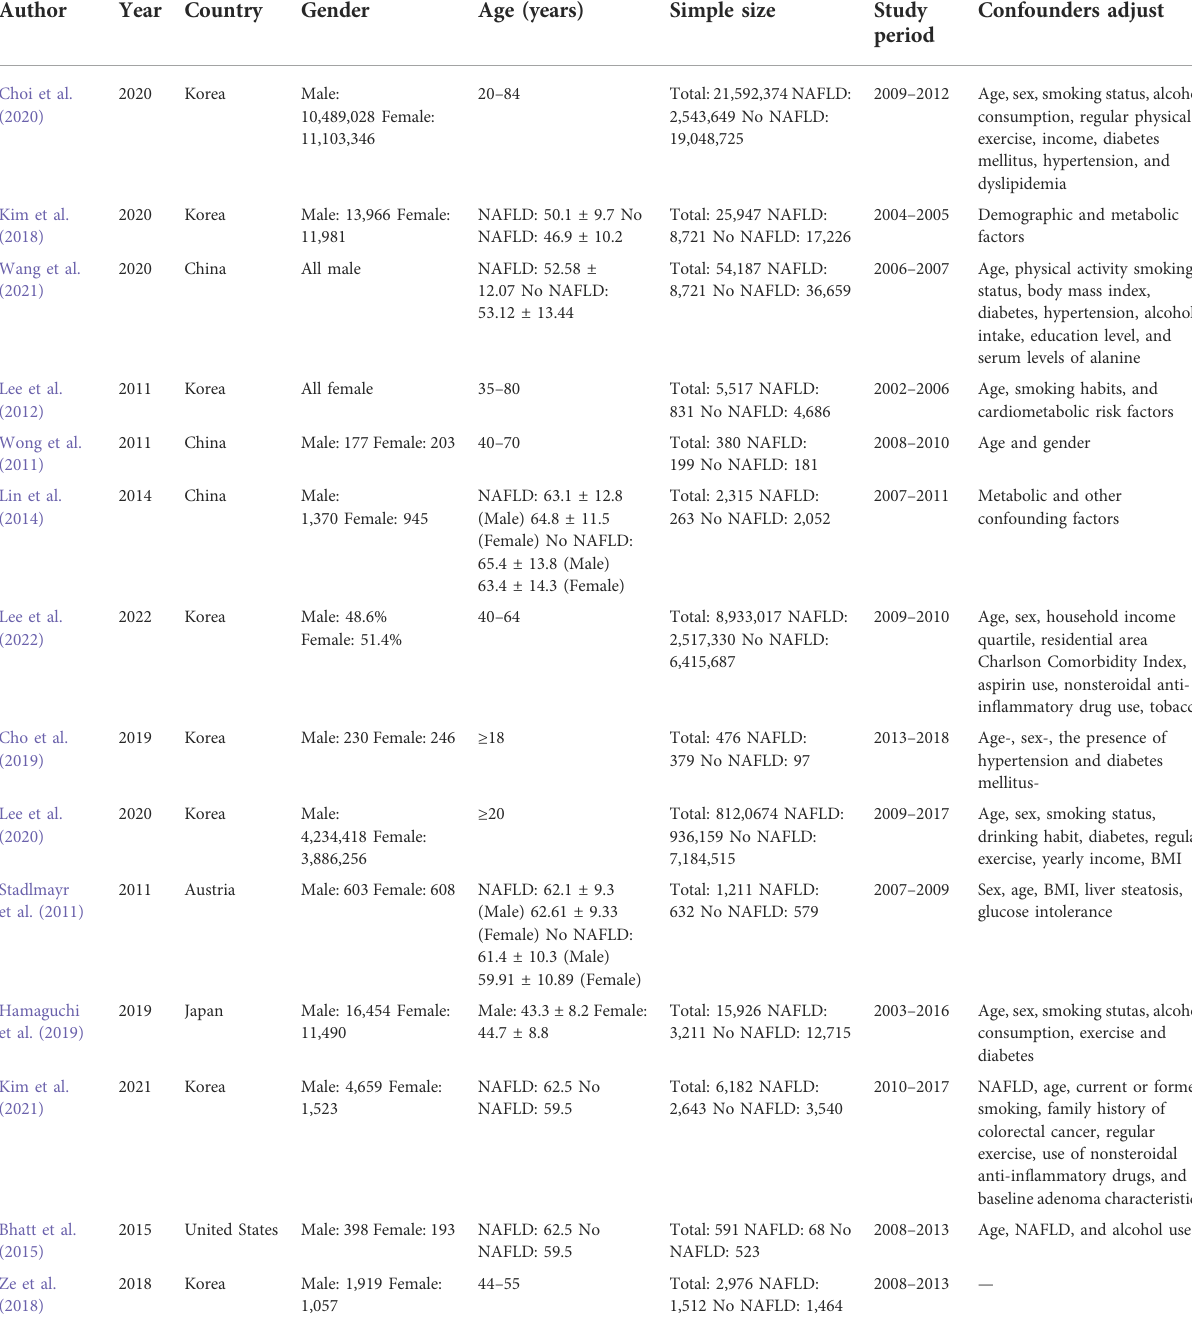
TABLE 1 Basic characteristics of the included